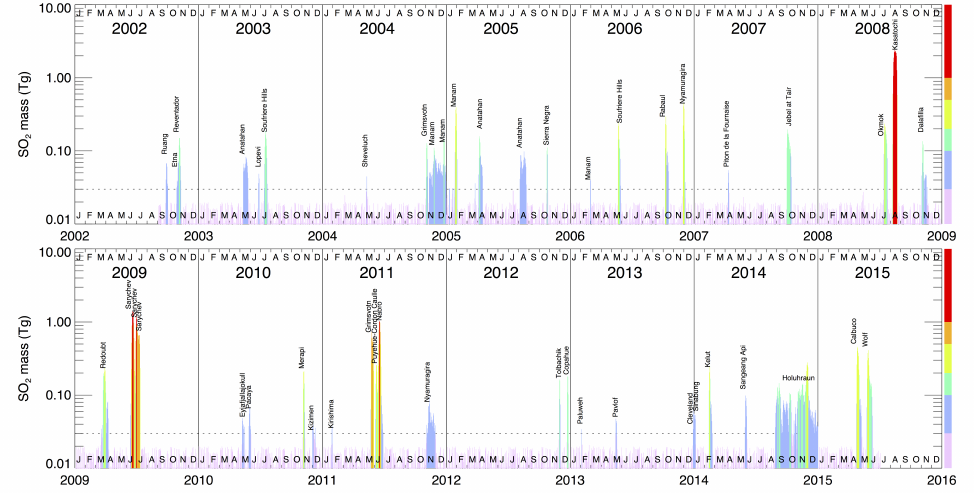
Figure 22. SO 2 total masses for 2002–2015 derived from